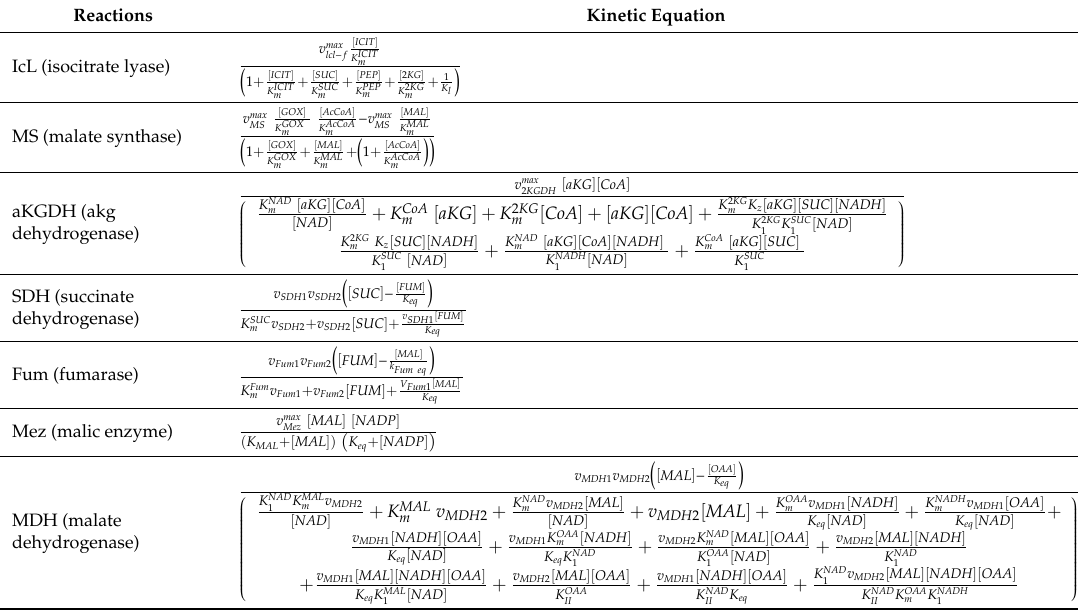
Table A3, describes the kinetic parameters segmentation of the proposed algorithm. Table A3. Kinetic parameters segmentation.